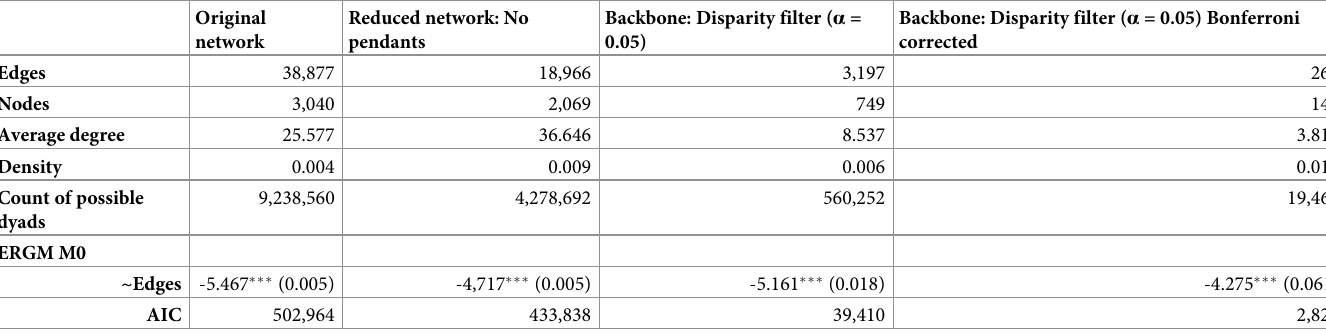
Table 2. Descriptive statistics illustrating the effects of structural